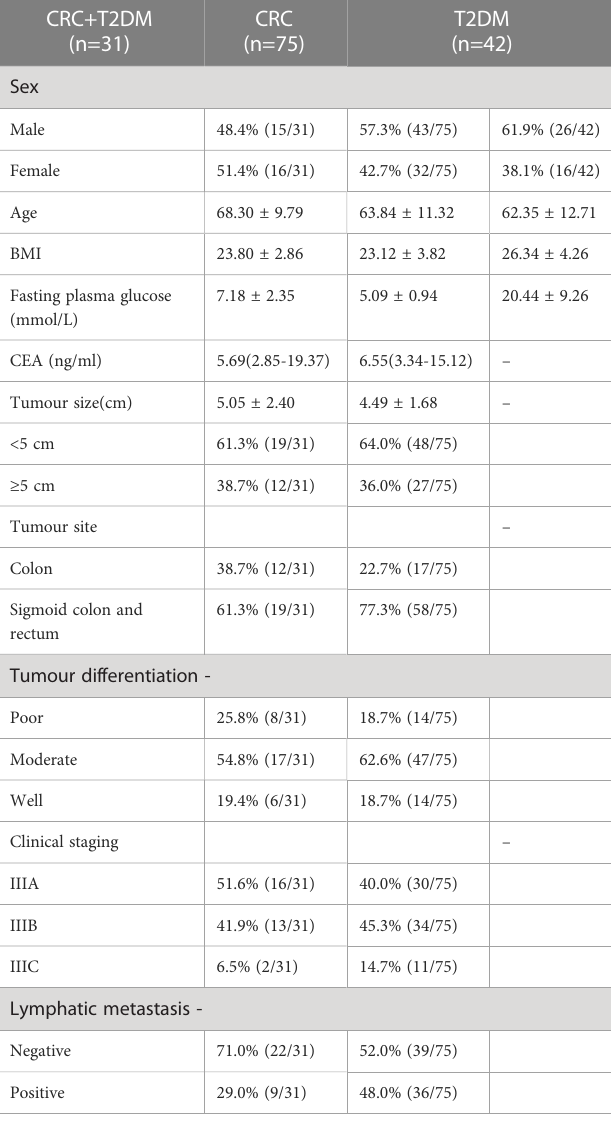
TABLE 1 Basic characteristics of the included